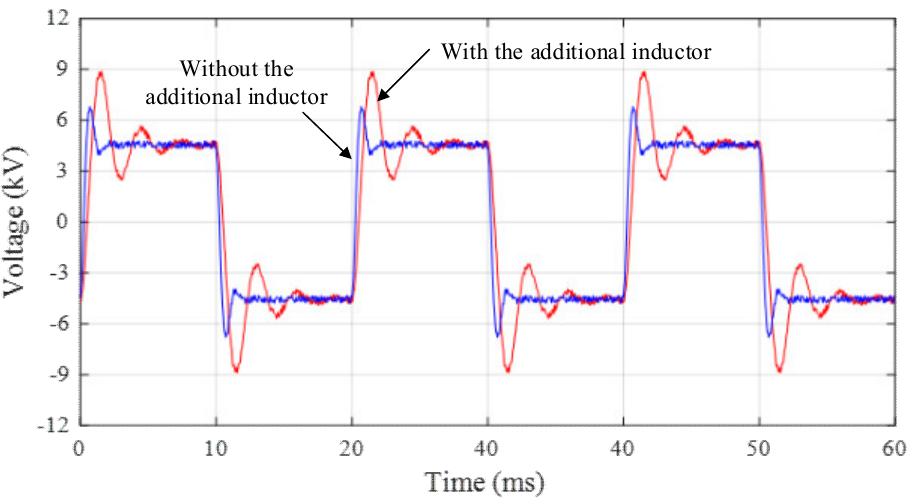
Figure 10. The measured output voltage waveforms and application of the square voltages at the input port of the testing system.